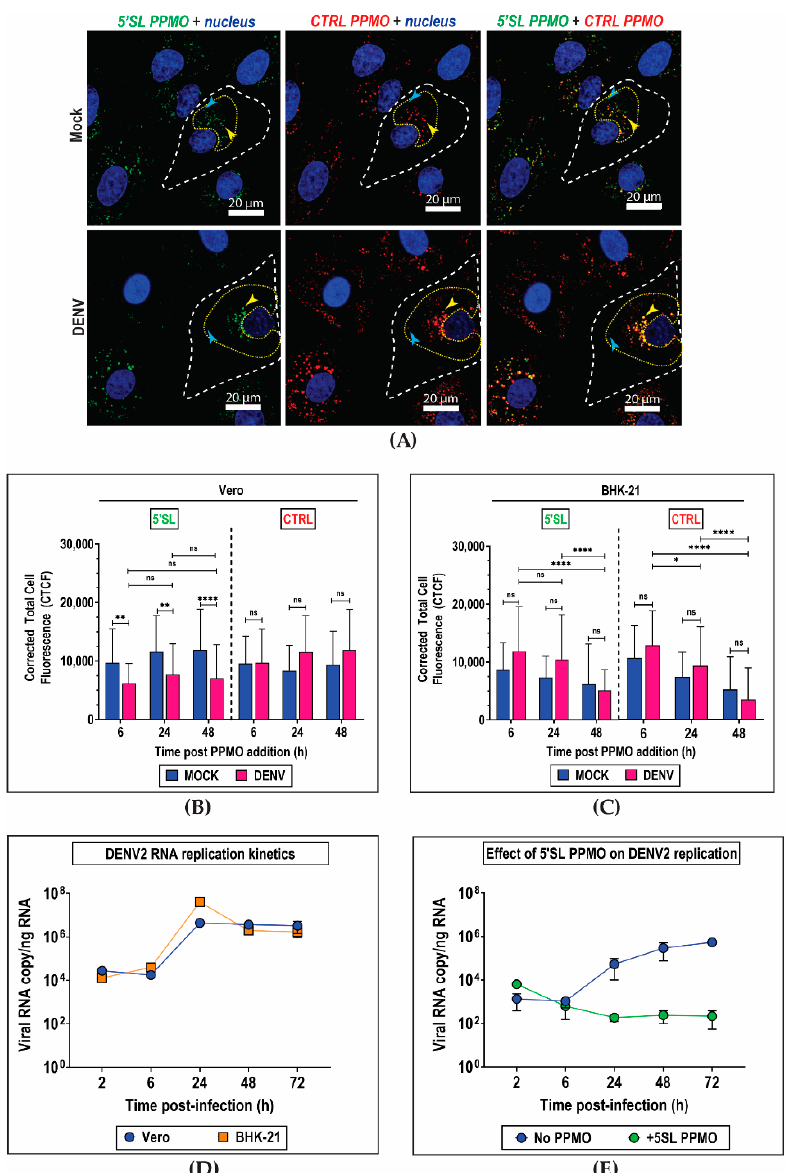
Figure 3. Live-cell monitoring of Dengue virus infection with PPMOs. ( A ) Representative deconvoluted fluorescent images of live monkey kidney (Vero) cells at 6 h post-infection. Cells are infected with 1 MOI Dengue virus serotype-2 (DENV2) for 1 h and immediately pulsed with either DENV2-targeted 5 ′ SL and non-targeted CTRL PPMOs (10 µM final concentration, 10 min). The cell boundary is outlined in white dashed lines, and sample regions of interest (ROIs) used in fluorescence signal quantification are outlined in yellow dotted lines. Sample foci where the PPMOs colocalize are indicated by the yellow arrows, and where the PPMOs do not colocalize are indicated by the blue arrows. ( B , C ) Quantification of fluorescence signals over time within DENV2-infected and mock-infected ( B ) Vero and ( C ) baby hamster kidney (BHK-21) cells incubated with both 5 ′ SL and CTRL PPMOs. The Corrected Total Cell Fluorescence (CTCF) is calculated by subtracting the contribution of background intensity from the integrated fluorescence density within the ROIs. ( D ) DENV2 replication kinetics in Vero and BHK-21 cells infected with 1 MOI virus ( n = 6). ( E ) DENV2 replication kinetics in Vero cells infected with 1 MOI virus in the presence of 10 µM 5 ′ SL PPMO ( n = 6). Cells are pulsed with PPMOs at 1 h post-infection. Mean values in ( B – C ) are compared with two-way ANOVA. *, p < 0.05; **, p < 0.005; ****, p < 0.0001; ns, not